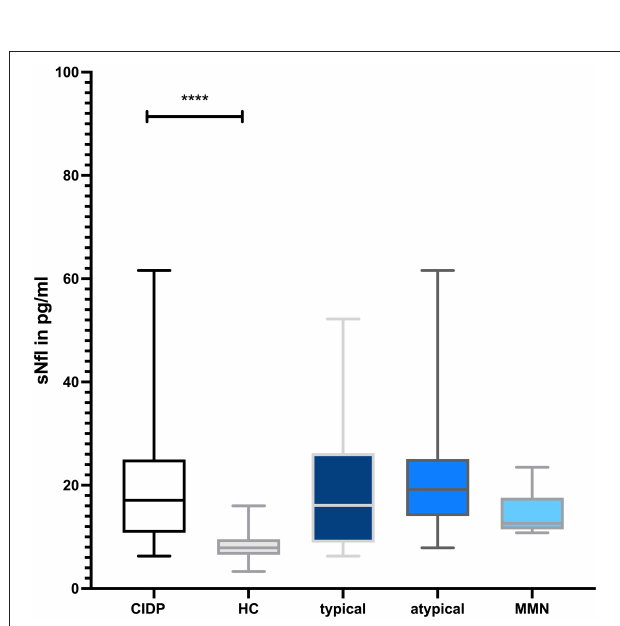
FIGURE 2 | Comparison of sNfl level in CIDP and HC. The boxplot bar represents median (min.–max.) of serum neurofilament (sNfl) level in all CIDP patients ( n = 63) and HC ( n = 30). Median sNfl levels were significantly increased in all CIDP patients regardless of subtype ( p < 0.001) (typical: n = 31, atypical: n = 32, MMN n = 6).